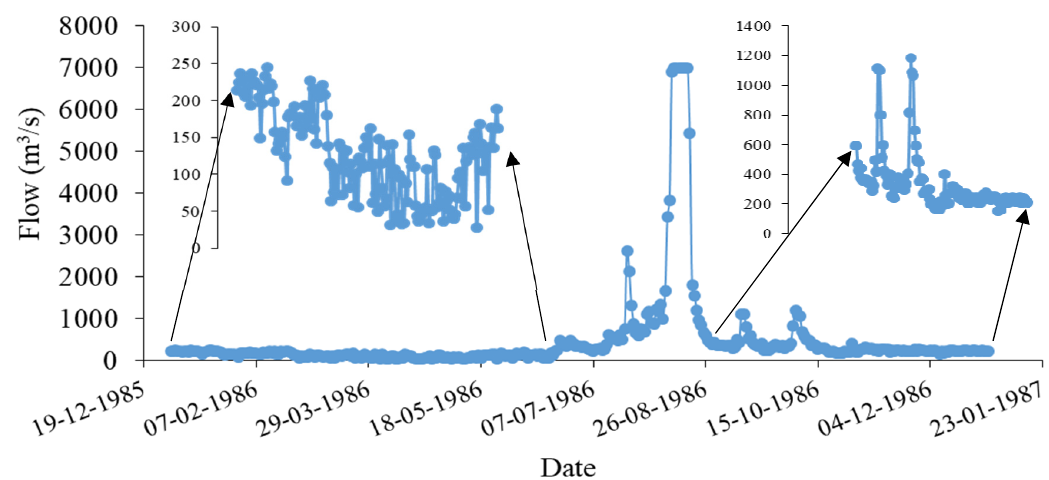
Figure 6. Flow hydrograph data considered for upstream boundary condition at Konta for the year 1986.